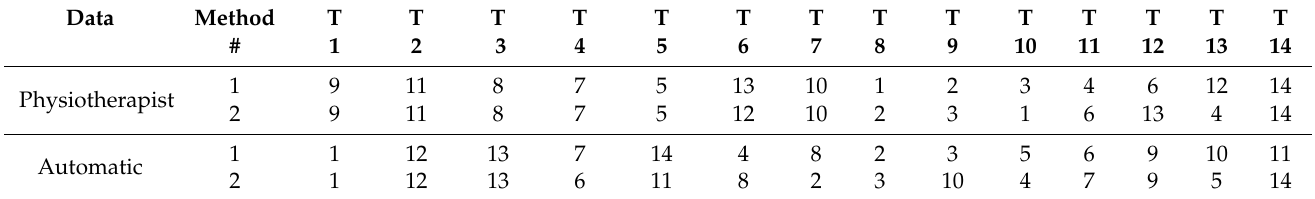
Table 4. E-BBS order of tasks using Methods 1 and 2. Task numbers are the standard BBS task numbers